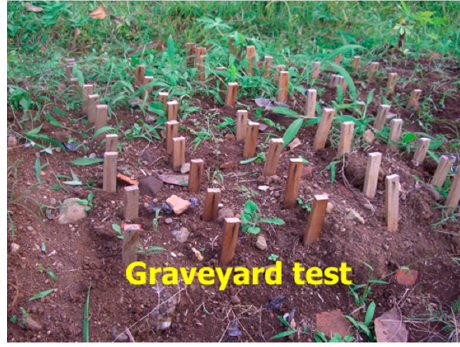
Figure 2. Field test of the specimens. Table 1. Rating system of wood resistance against termite attack.